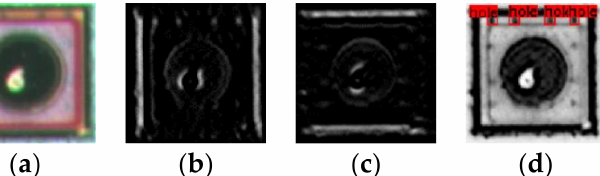
Figure 9. Conductive-hole exposing: ( a ) initial picture; ( b ) convolution Dst 1; ( c ) convolution Dst 2; ( d ) extracting.